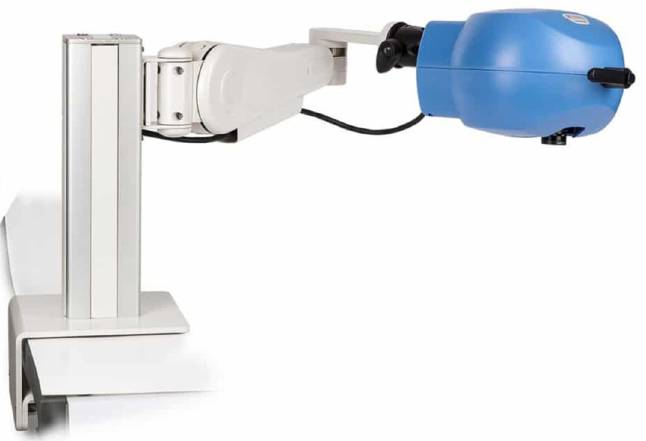
Figure 3. Laser speckle contrast analysis (LASCA) is composed of: a head, an adjustable arm, a de ‐ tector camera, and a software for data acquisition and analysis. (Courtesy by Perimed).